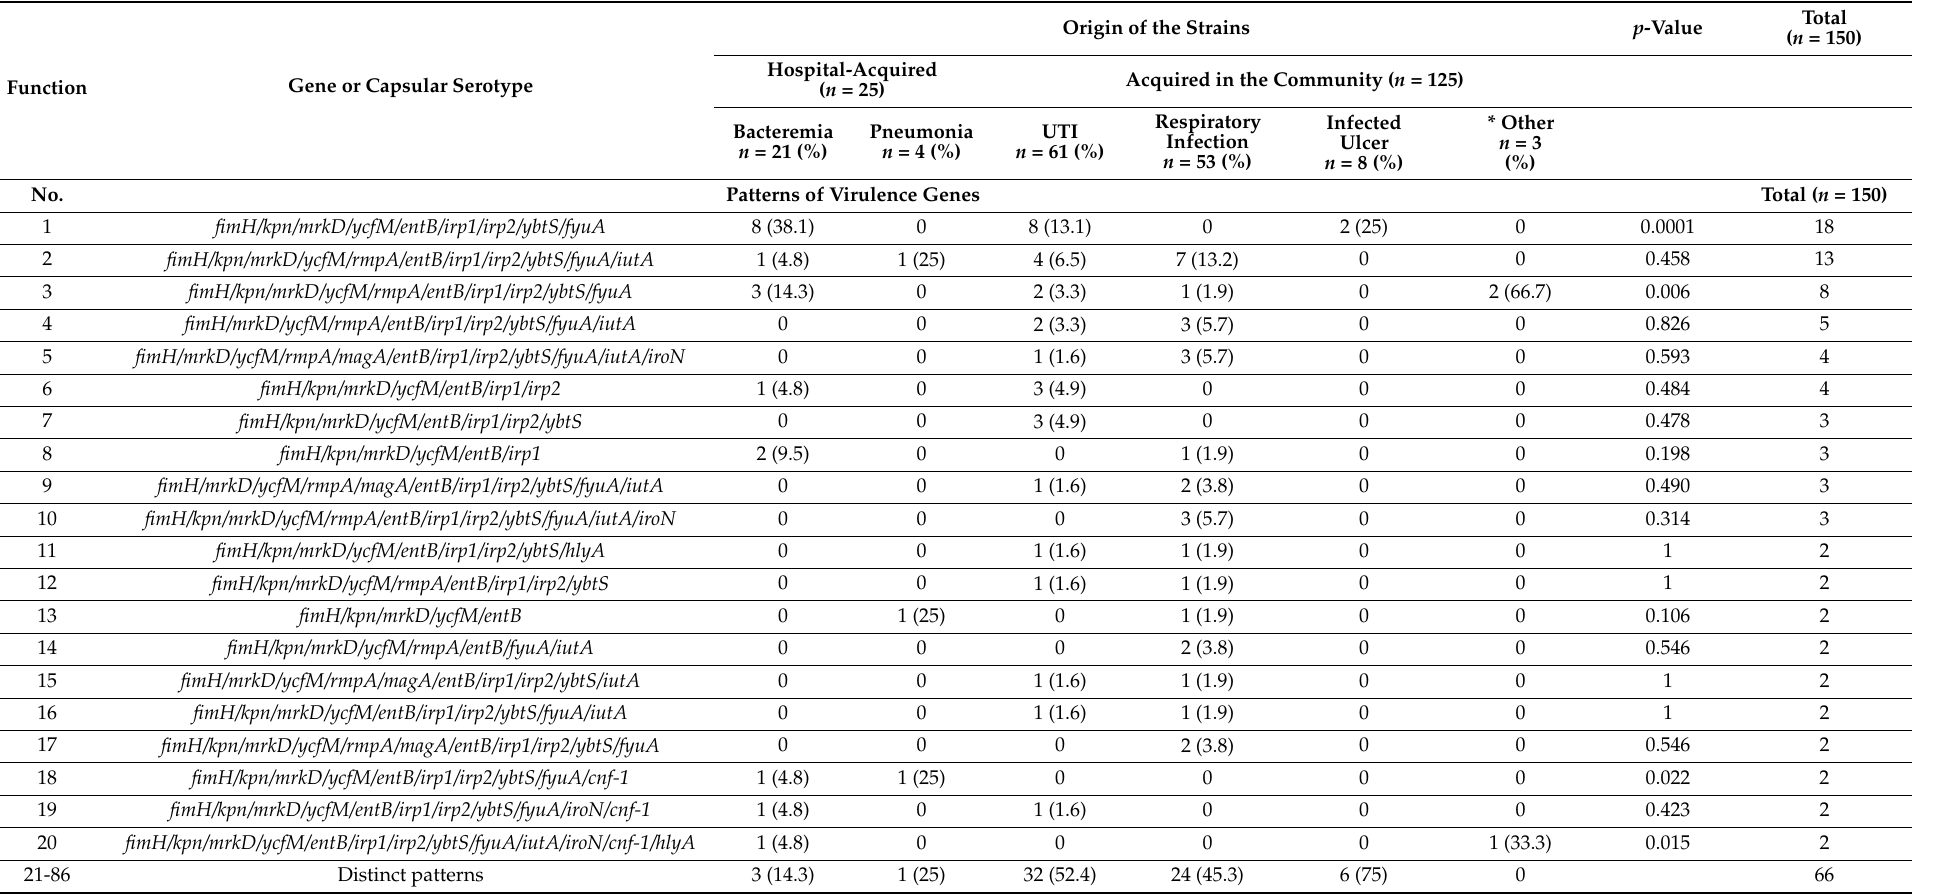
Table 2. Distribution of virulence gene association patterns in strains of K. pneumoniae isolated from patients with hospital- and community-acquired infections. Origin of the Strains p -Value Total ( n = Function Gene or Capsular Serotype